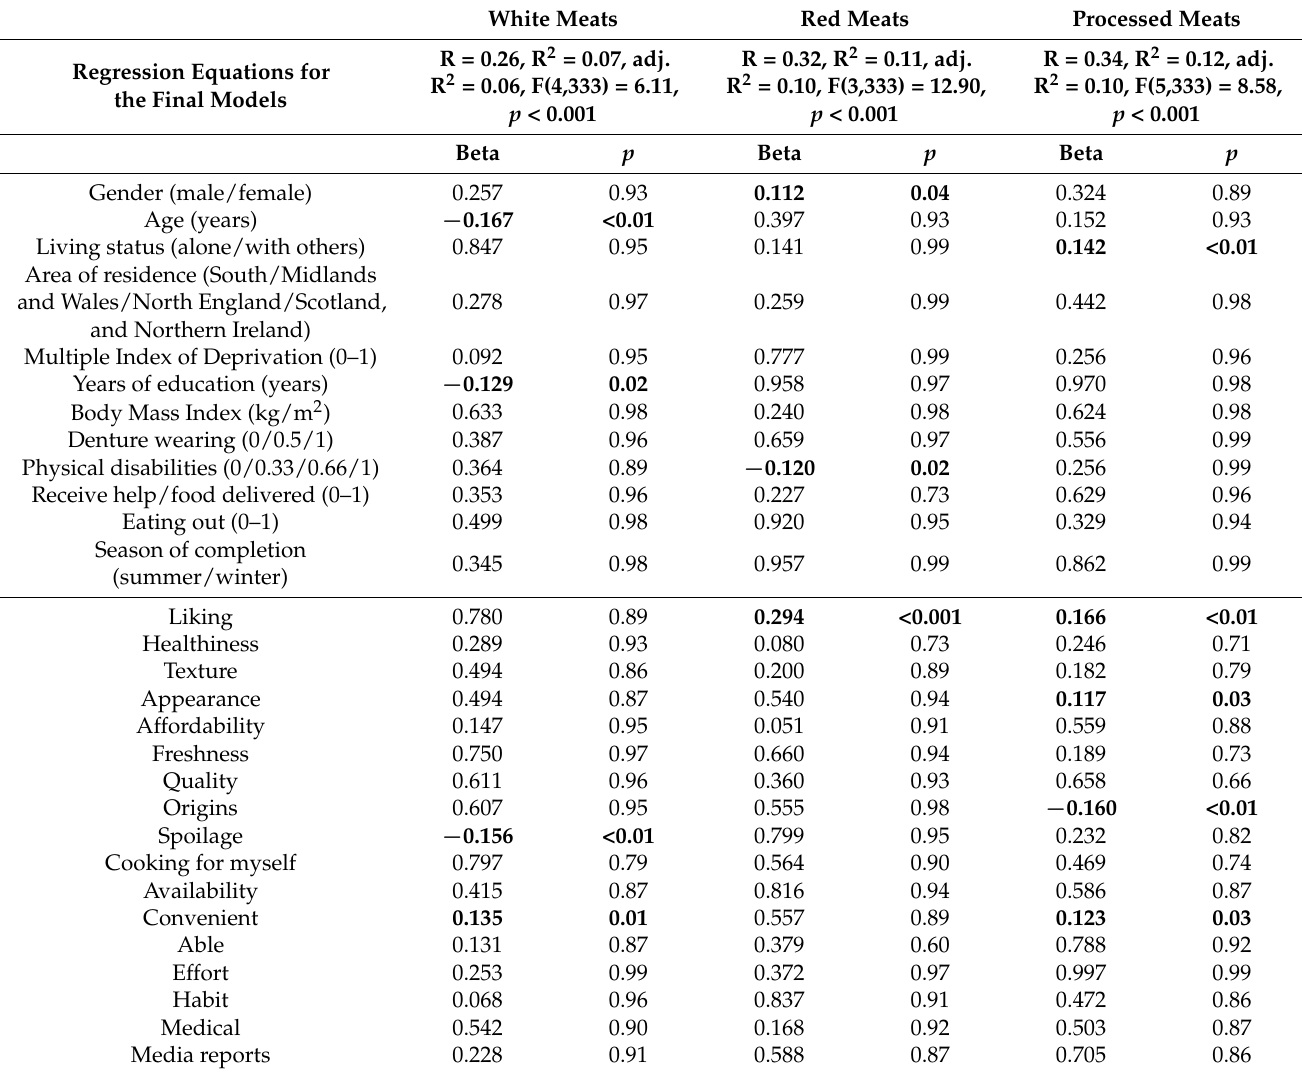
Table 1. Results of all regression analyses for meat consumption (N = 340). White Meats Red